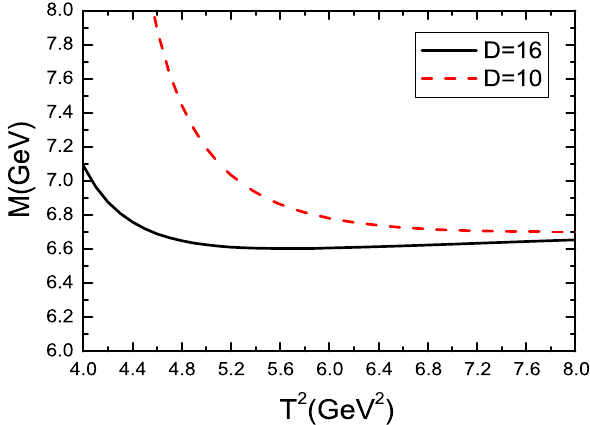
Fig. 5 The mass of the Z ++ cc with variation of the Borel parameter T 2 , where the D = 16 and D = 10 denote the truncations in the operator product expansion